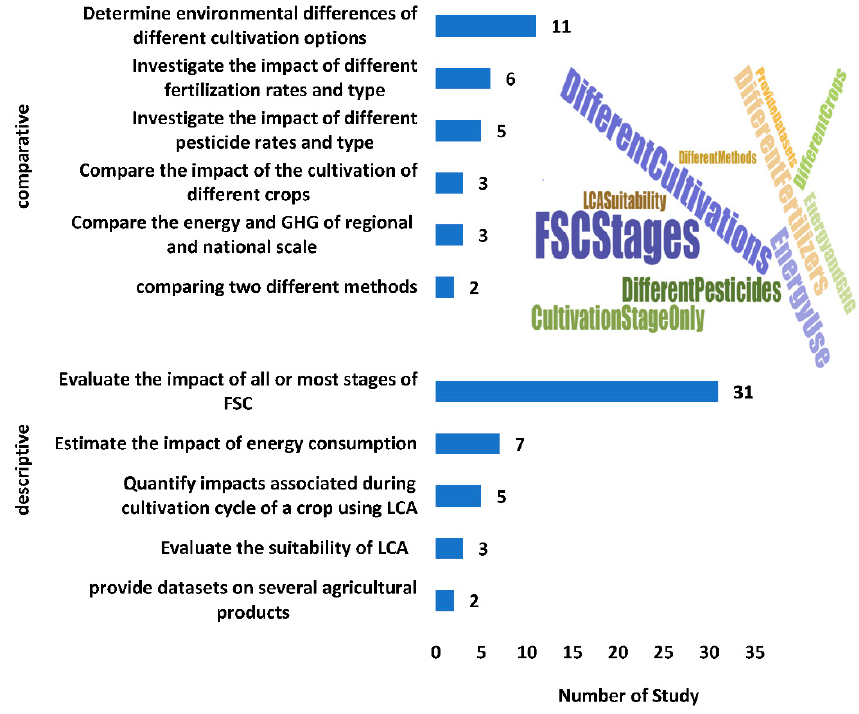
Figure 5. Quantitative and qualitative representation of the common aims of LCA from the litera- ture.